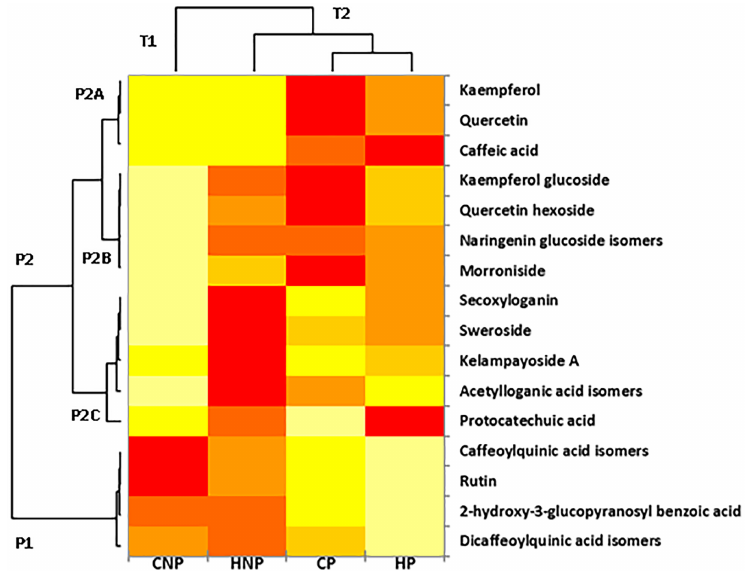
Fig 4. Heatmap calculated from quantitative data of polyphenol concentrations in the four different treatments (CNP, HNP, CP and HP). The color scale moves from yellow to red with increased content. The clusters P1, P2, T1 and T2 refer to the polyphenol classes and to the technological treatments, respectively. CNP: Cold water extraction without pectinase, HNP: Hot water extraction without pectinase, HP: Hot water extraction with pectinase, CP: Cold water extraction with